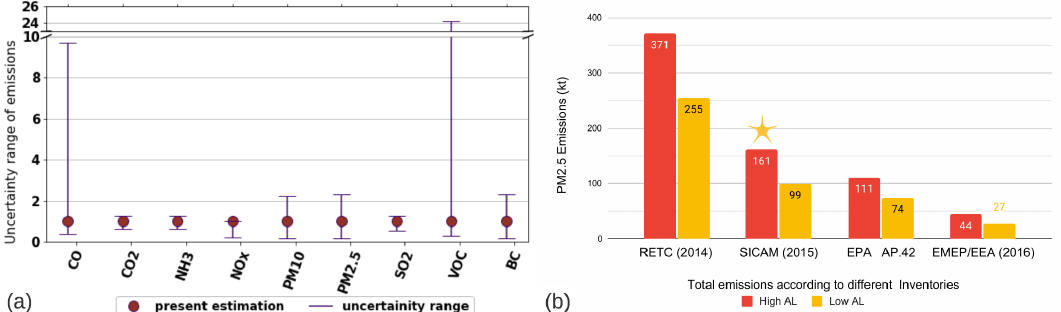
Figure 9. (a) Uncertainty range of residential emissions considering the possible estimation that can be made with the different sources of information evaluated in this work. The units on the y axis are the ratio of total 2017 emissions from one set of assumptions to the INEMA estimate. The y axis is broken up for better visualization (b) with the 2017 PM 2 . 5 emission uncertainty range disaggregated according to different emission factors (groups of columns) and activity levels (colors). In yellow are the inventories constructed using CDT information, which provides the lowest possible activity level (AL), while in red are the activity levels used in this inventory (Sect. 2.1). The first group of columns represents estimated PM 2 . 5 emissions based on EF from RETC, while the second group corresponds to the estimate based on EF used in the current inventory (the bar used on INEMA’s inventory is marked with a star). The third and fourth group of columns correspond to the estimate based on EF proposed by US EPA (1996a, b) and EMEP/EEA (2019), respectively. US EPA emission factors come from Compilation of Air Emission Factors (AP-42), available at https://www.epa.gov/air-emissions-factors-and-quantification/ ap-42-compilation-air-emissions-factors (last access: 13 October 2022).